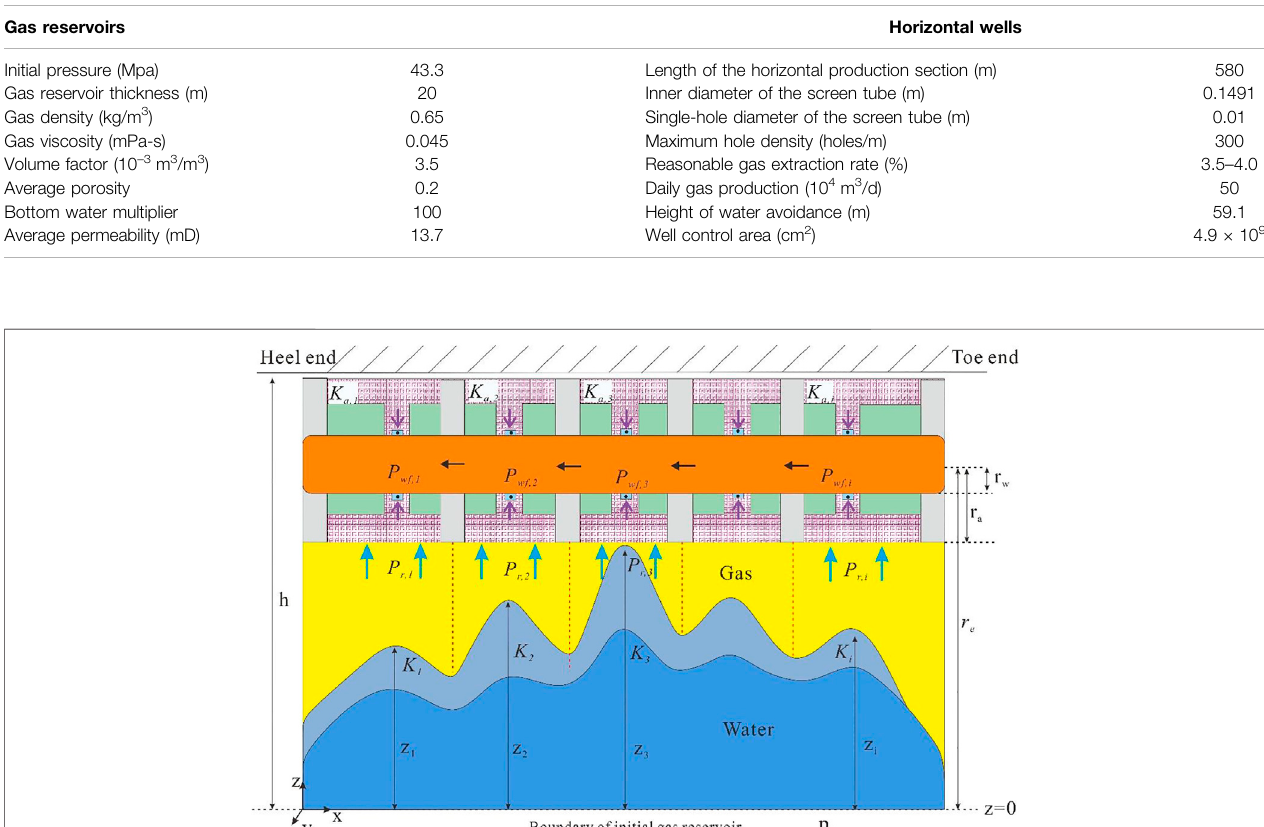
TABLE 1 | Main relevant parameters for numerical simulation experiments.